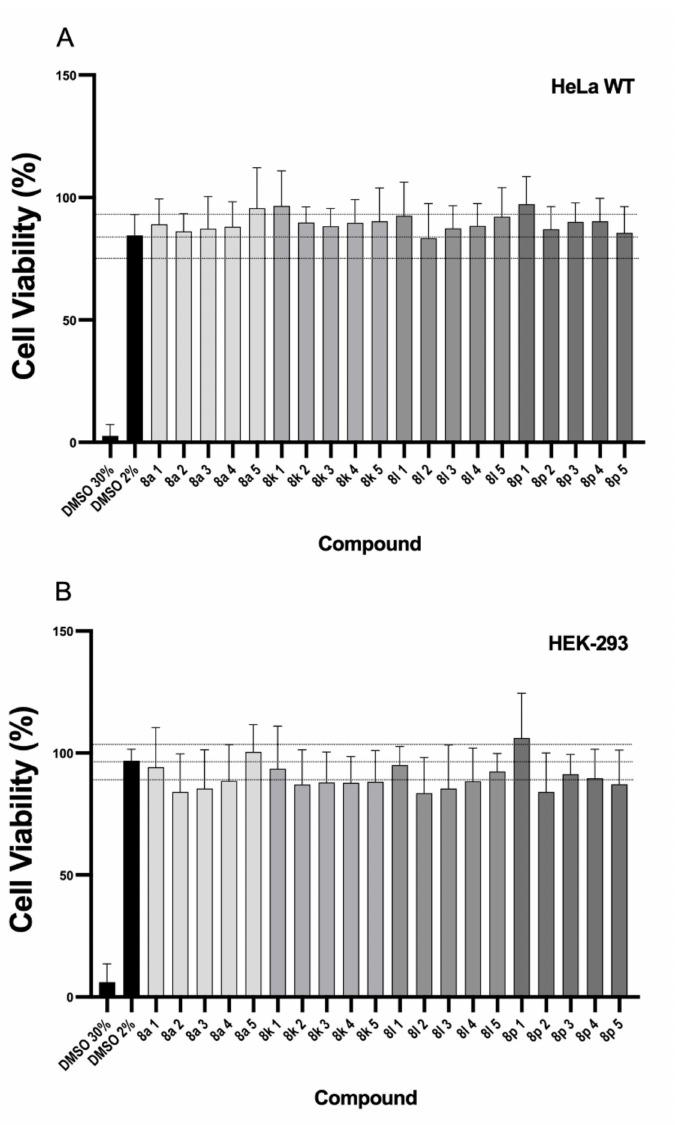
Figure 6. Effect of the selected compounds on cell viability using the CCK-8 assay in ( A ) HeLa and ( B ) HEK93 cell lines. Concentrations used were 10 mM (1), 100 µ M (2), 10 µ M (3), 100 nM (4), and 10 nM (5). The upper and lower lines define ± 2 SD limits from the average value of control wells treated only with the vehicle (DMSO 2%). All values are means ± SD ( n = 3). SD: standard